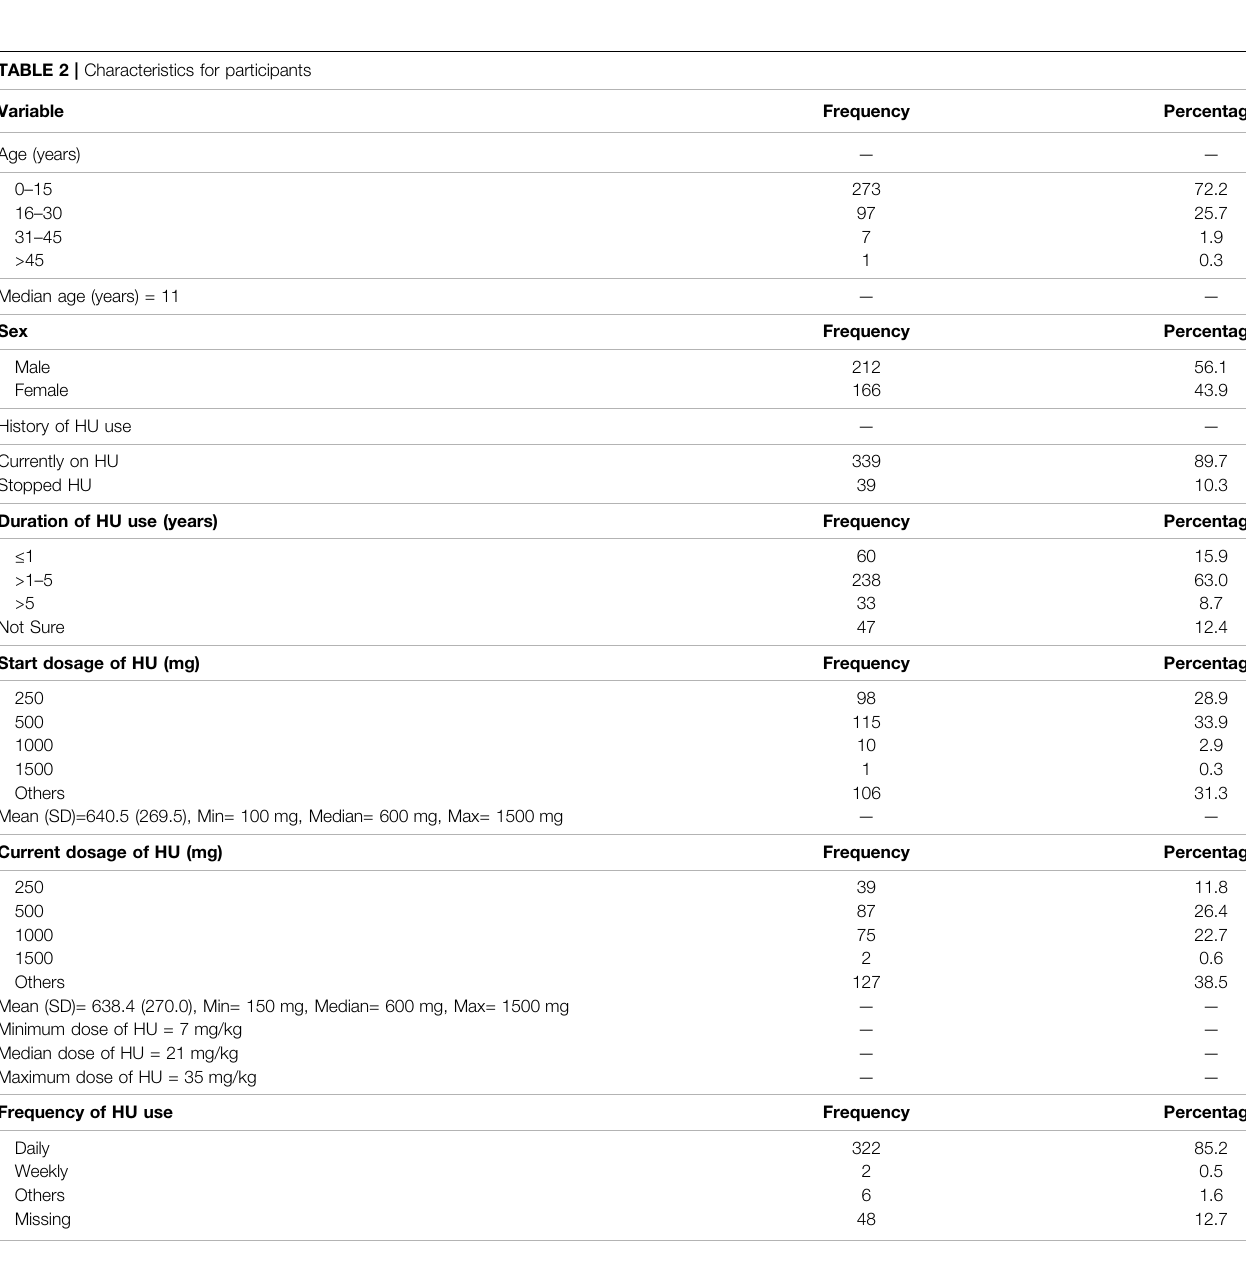
TABLE 2 | Characteristics for